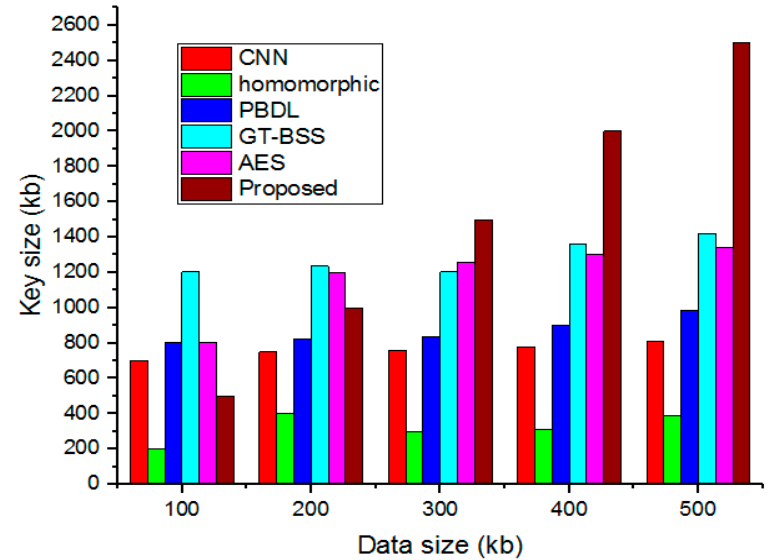
Figure 8. Comparative analyses of key sizes.